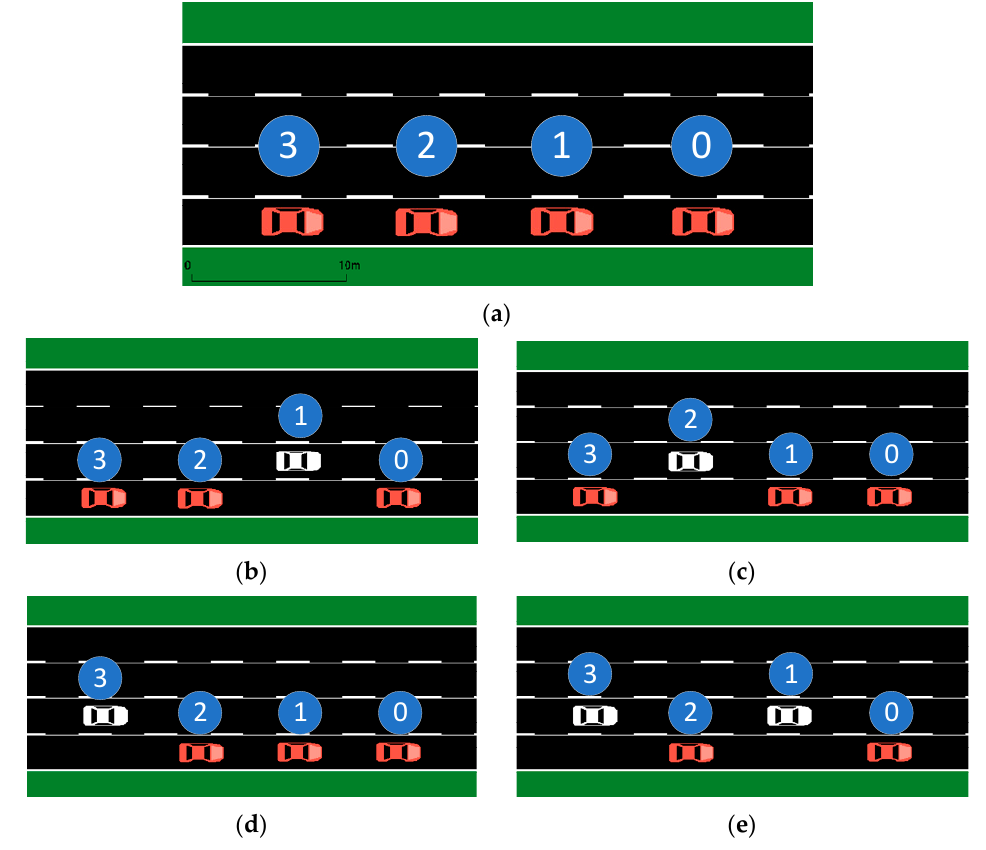
Figure 1. Decision making: slowing down and changing lanes. ( a ) No action; ( b ) the 1st member car changing lanes; ( c ) the 2nd member car changing lanes; ( d ) the 3rd member car changing lanes; ( e ) the 1st and 3rd member cars changing lanes.